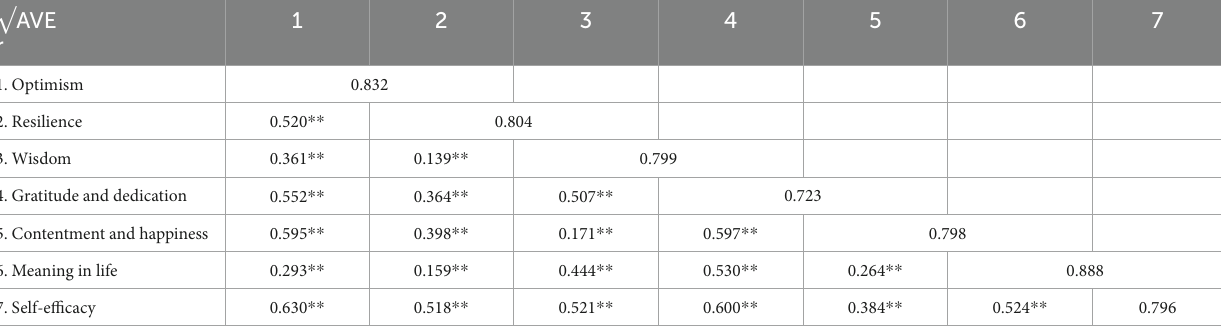
TABLE 6 Fornell-Larcker criterion analysis of the revised PsyCap scale ( N = 370). √ AVE r